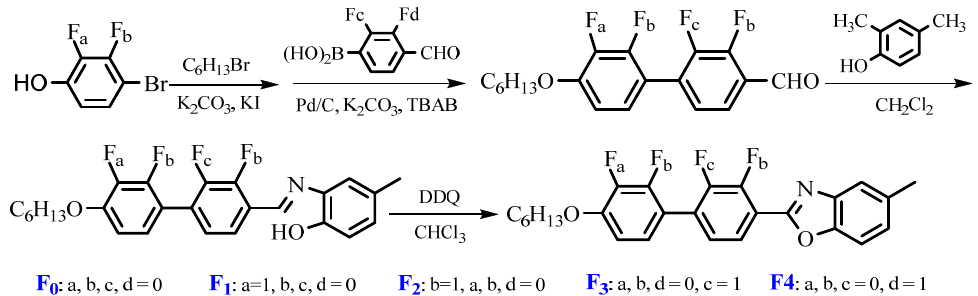
Figure 8. Synthesis route of fl uorinated benzoxazole LC compounds.